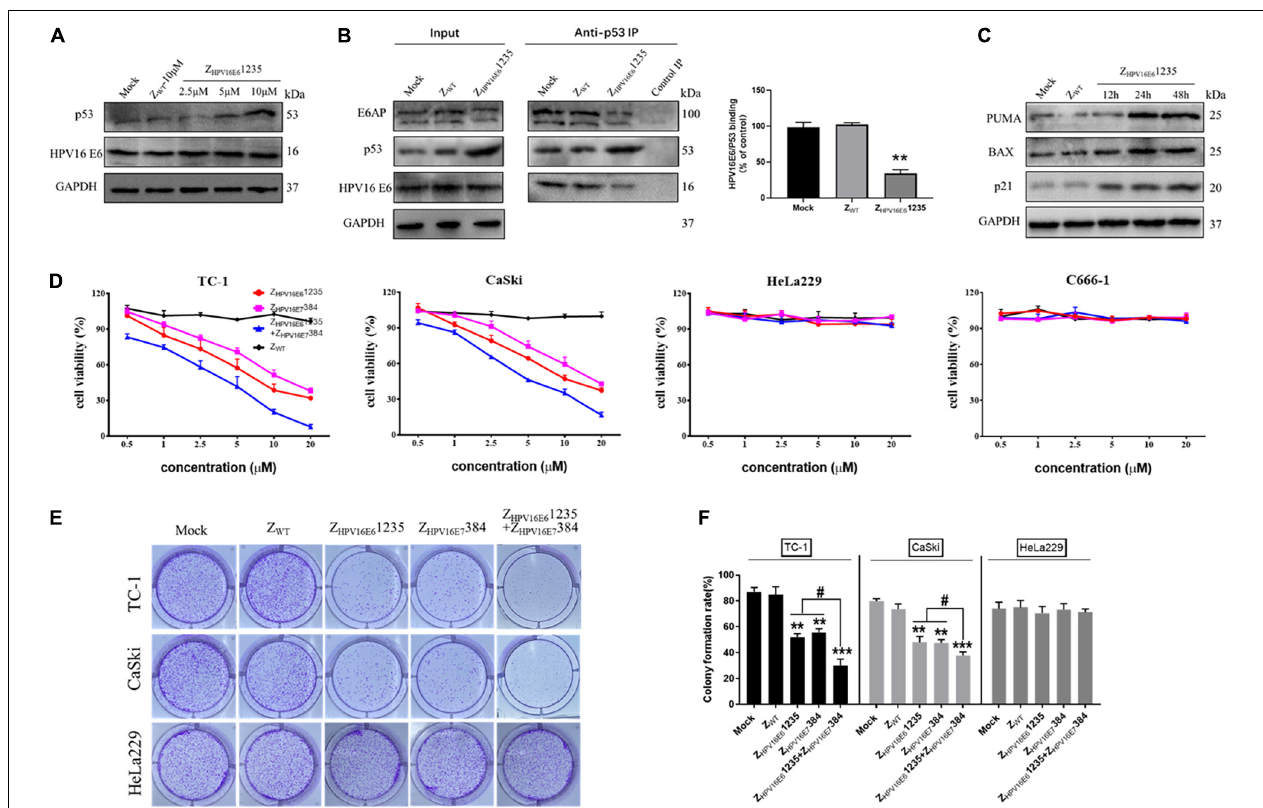
FIGURE 5 | Z HPV16E6 1235 inhibits the proliferation of HPV16-positive cell lines by binding to and blocking the intracellular activity of the HPV16 E6 oncoprotein. (A) p53 was up-regulated in a dose-dependent manner by treatment with Z HPV16E6 1235 in CaSki cells. (B) The effect of Z HPV16E6 1235 on the intracellular binding between HPV16 E6 and p53 was assessed by immunoprecipitating the E6/E6AP/p53 trimeric complex using an anti-p53 antibody bound to Protein A/G agarose beads from CaSki cells treated for 24 h. A parallel negative control assay was run for each group by incubating cell lysates with control IgG. The bar graph represents the amount of E6 bound to the relative amount of immunoprecipitated p53 after the quantification of p53 and E6 protein bands with ImageJ software. Data are presented as the mean ± SD of three independent experiments. ** P < 0.01. (C) CaSki cells were treated with 10 µ M Z HPV16E6 1235 for the indicated periods and the expression of p53 target genes, including PUMA, BAX and p21, was evaluated by Western blotting. Cells without any treatment (Mock) or treated with 10 µ M Z WT for 48 h were used as negative controls. GAPDH served as an internal reference standard. (D) The effects of Z HPV16E6 1235 and Z HPV16E7 384 alone or in combination on the viability of HPV16-positive cancer cells (TC-1, CaSki), HPV18-positive cervical cancer cells (HeLa229) and HPV-negative cancer cells (C666-1) were assessed by CCK-8 assay after 48 h of treatment with the indicated concentrations; these cells were compared to Z WT -treated cells. Data are shown as the mean ± SD of three independent experiments. (E–F) Colony formation assays of HPV16-positive TC-1 and CaSki cells or HPV18-positive HeLa229 cells following treatment with 2.5 µ M test affibody molecules for 14 days. The Z WT affibody and medium groups were set as controls. ** P < 0.01, *** P < 0.001 vs. the control group. # P < 0.05 vs. the Z HPV16E6 1235 or Z HPV16E7 384 alone treatment